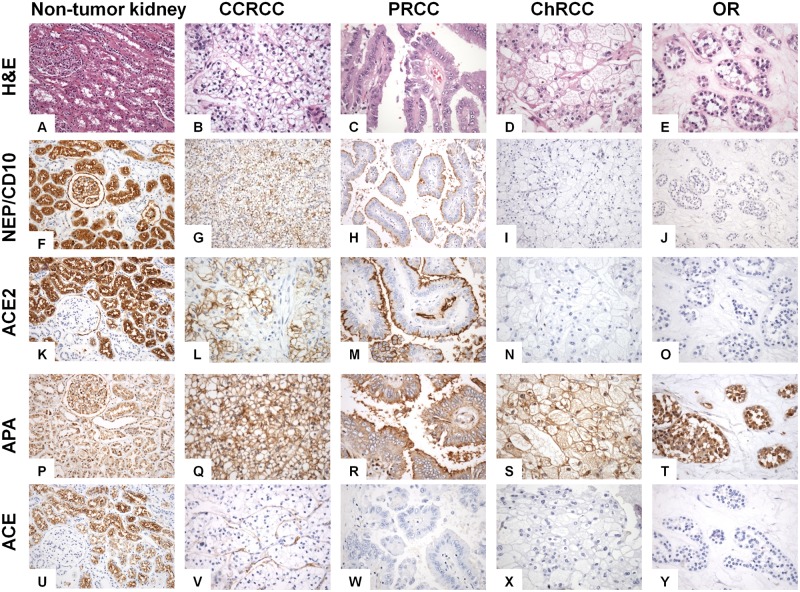
Plate showing the hematoxylin and eosin (H&E) staining of normal kidney (A), clear cell renal cell carcinoma (CCRCC) (B), papillary renal cell carcinoma (PRCC) (C), chromophobe renal cell carcinoma (ChRCC) (D) and renal oncocytoma (RO) (E) and immunohistochemical pattern displayed for four peptidases (NEP/CD10, ACE2, APA and ACE) (test performed in formalin-fixed and paraffin-embedded material). NEP/CD10 immunostaining was positive in proximal convoluted tubules of the normal kidney (F), as well as in about half CCRCC (membranous) (G) and PRCC (apical membranous) studied samples (H). By contrast, it was negative in ChRCC (I) and RO (J). ACE2 immunostaining was positive also in proximal convoluted tubules of the normal kidney (K), as well as in CCRCC (membranous) (L) and PRCC (apical membranous) (M). By contrast, it was negative in almost 60% of ChRCC (N) and in all RO (O). APA immunostaining was diffusely positive in normal kidney (tubules and glomeruli) (P), as well as in CCRCC (membranous) (Q), PRCC (membranous) (R), ChRCC (membranous and cytoplasmic) (S) and RO (cytoplasmic) (T). ACE immunostaining was positive in proximal convoluted tubules of the normal kidney (U). All CCRCC (V), PRCC (W), ChRCC (X) and RO (Y) were negative. Only neoplastic blood capillaries were positive in CCRCC (V). (Original magnification, x20 for uninvolved renal tissues, and x400 for tumors).